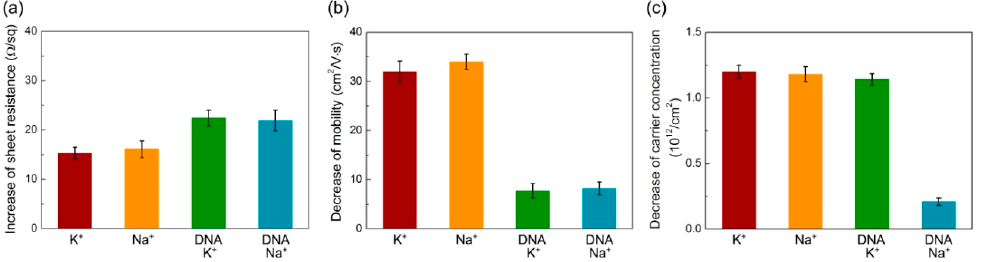
Figure 3. The variations of ( a ) sheet resistance; ( b ) mobility; and ( c ) carrier concentration of the graphene devices with and without DNA modification for distinguishing between K + and Na +